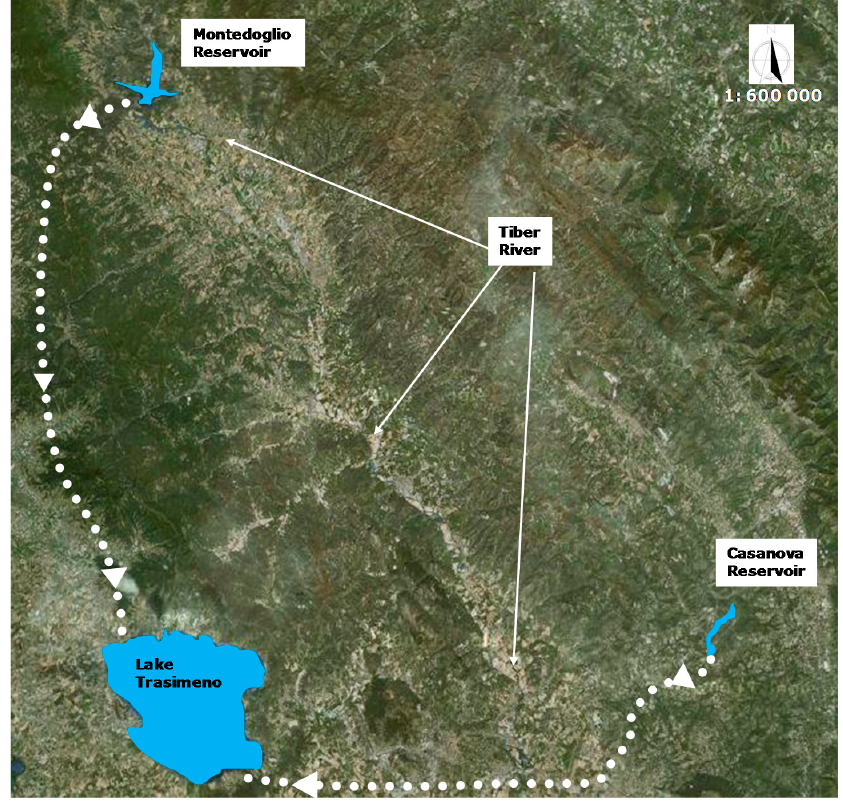
Figure 2. Scheme of the water management system (Google image 2010).